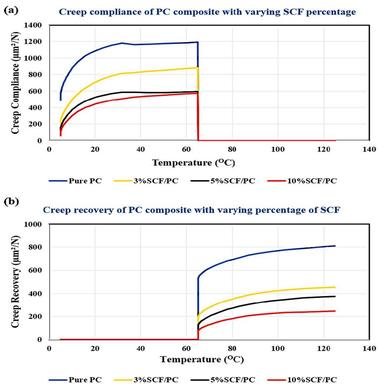
(a) Creep compliance (b) Creep recovery at 100 ◦C for different SCF percentage.